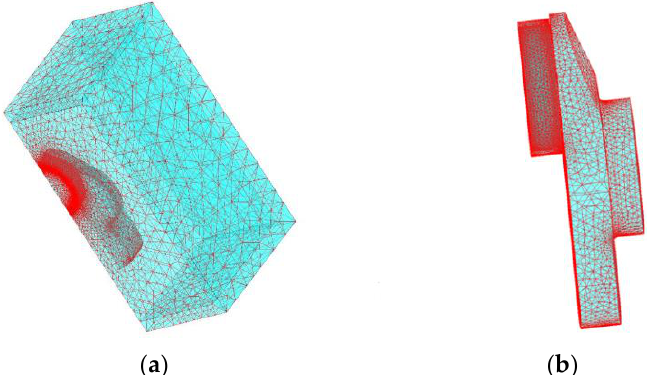
Figure 6. The finite element model of the crankshaft; ( a ) the quarter model in the far field; ( b ) the quarter model of the crankpin and the coil.